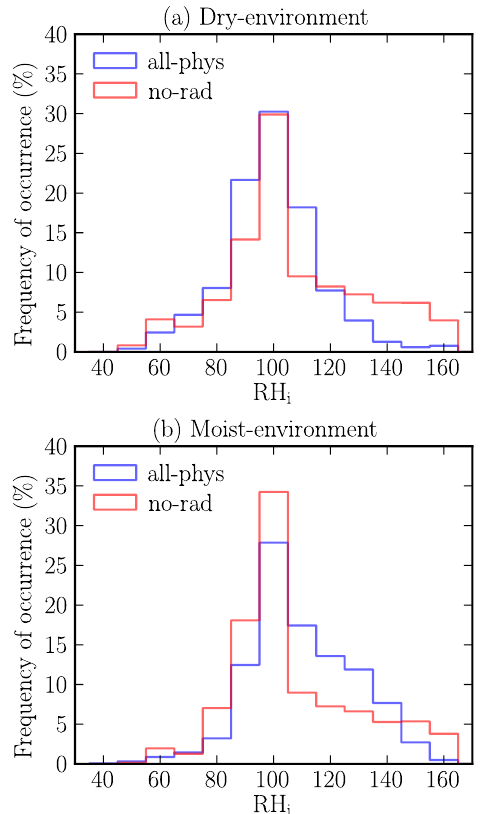
Figure 3. Frequency distribution of in-cloud relative humidities over the cloud